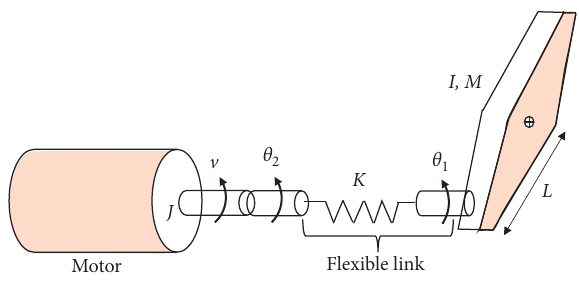
Figure 1: Single-link flexible-joint robot and the related